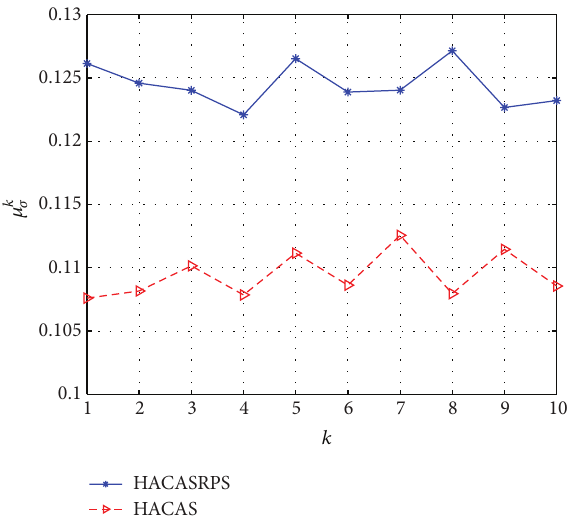
Figure 7: The load variations of HACAS and HACASRPS algo- rithms in different simulation cycles; 𝑘 is the simulation cycle, and 𝑘 th cycle. 𝜇 𝑘 𝜎 is the load variation of the algorithm in the